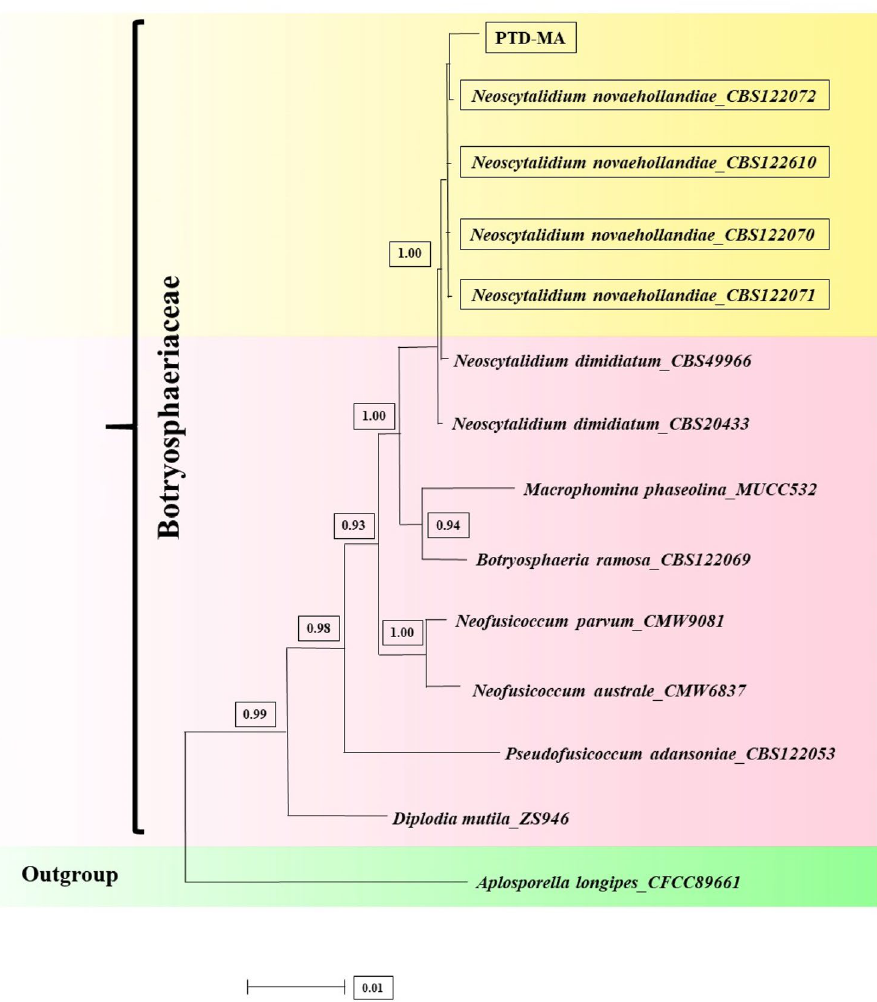
Figure 3. Bayesian tree inferred under the GTR + G model from the combined sequences of ITS and TEF1-α for Neoscytalidium novaehollandiae and related species of closest genus, using Aplosporella longipes 71 as outgroup. The sequences aligned using MAFFT software and edited using Gblocks program. Bayesian posterior probabilities more than 0.50 are given for appropriate clades. Newly obtained sequence and other isolates of N. novaehollandiae indicated by yellow framework. PTD-MA is the strain of this